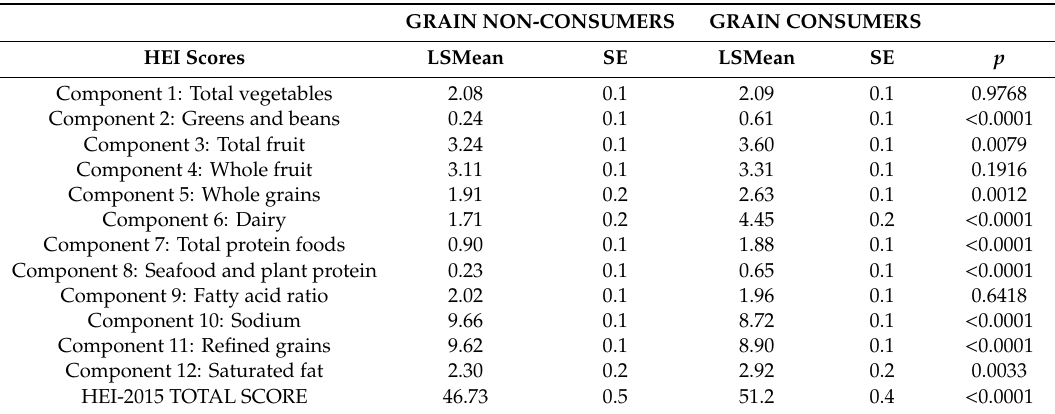
Table 3. Mean (standard error [SE]) total Healthy Eating Index-2015 and sub-component scores for 6- to 12-month-old grain consumers vs. grain